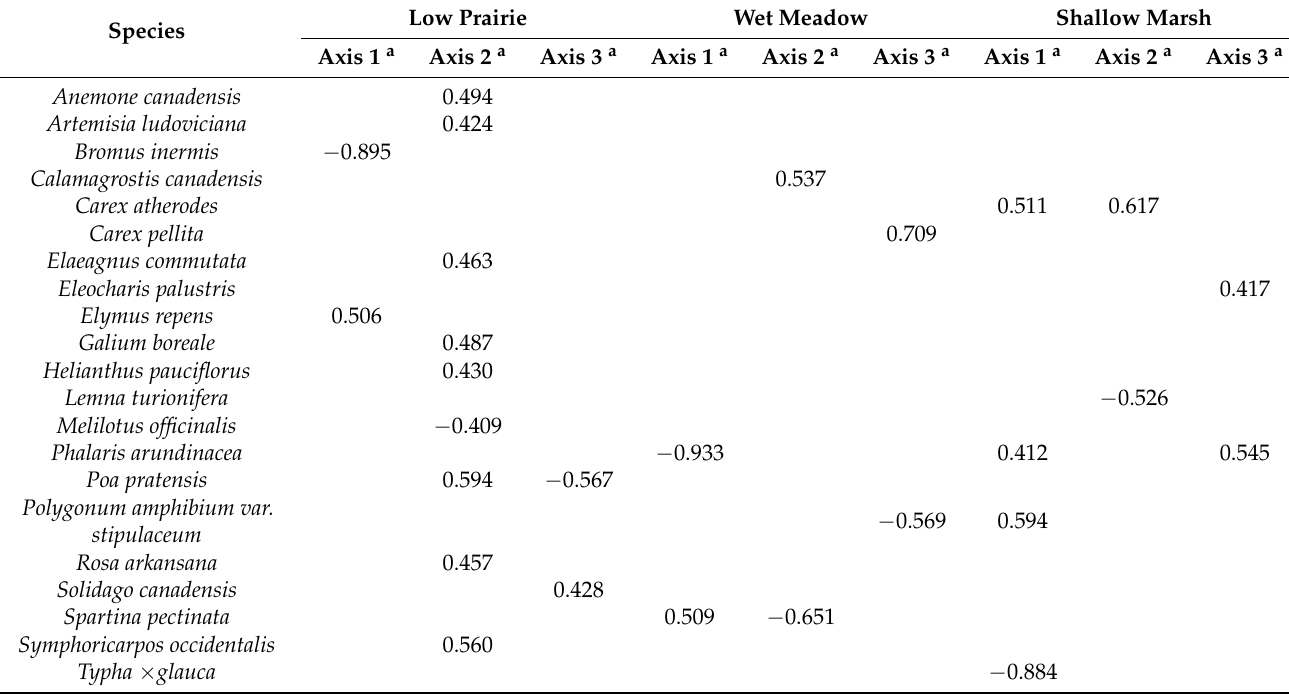
a Pearson correlation with NMS axes.